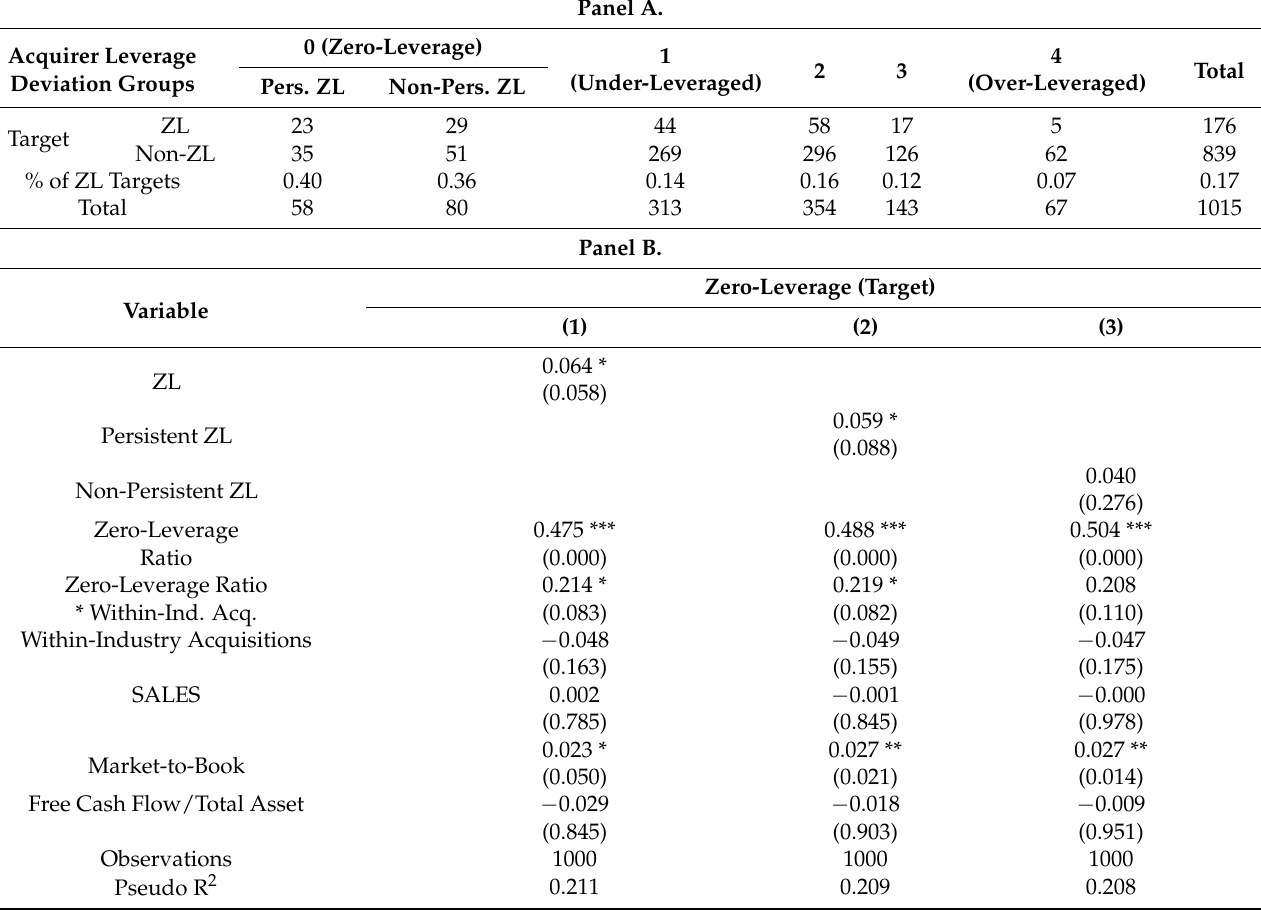
Table 7. The preference toward ZL targets. Panel A reports the number of ZL targets and non-ZL targets across different leverage deviation groups. Panel B shows the results of probit regressions, examining the effect of acquirer’s zero-leverage, under-leveraged, over-leveraged, and leverage deviation on the target’s zero-leverage and leverage deviation, respectively. The dependent variable in Columns (1)–(3) is the indicator variable for the target being ZL. All variables are defined in Appendix A. The average marginal effects of probit regressions are reported. Each regression includes year dummies. The p -values reported in parenthesis are based on standard errors